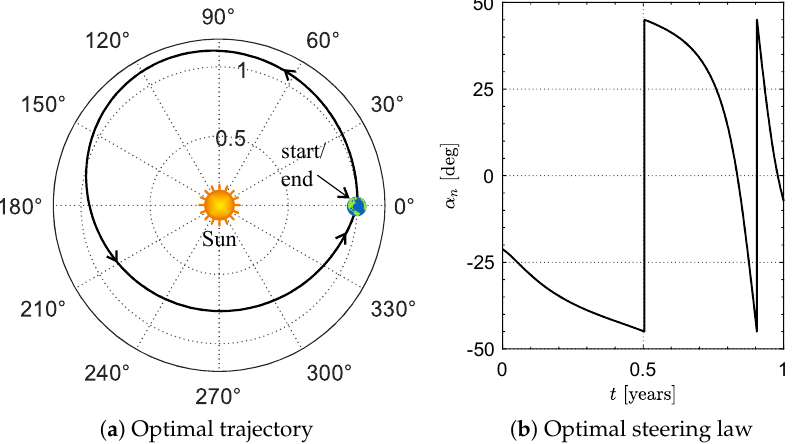
Figure 6. ∆ V -EGA maneuver trajectory and corresponding optimal steering law α n = α (cid:63) n ( t ) for = 1km/s, and t = a c = 1mm/s 2 , V ∞ f 0